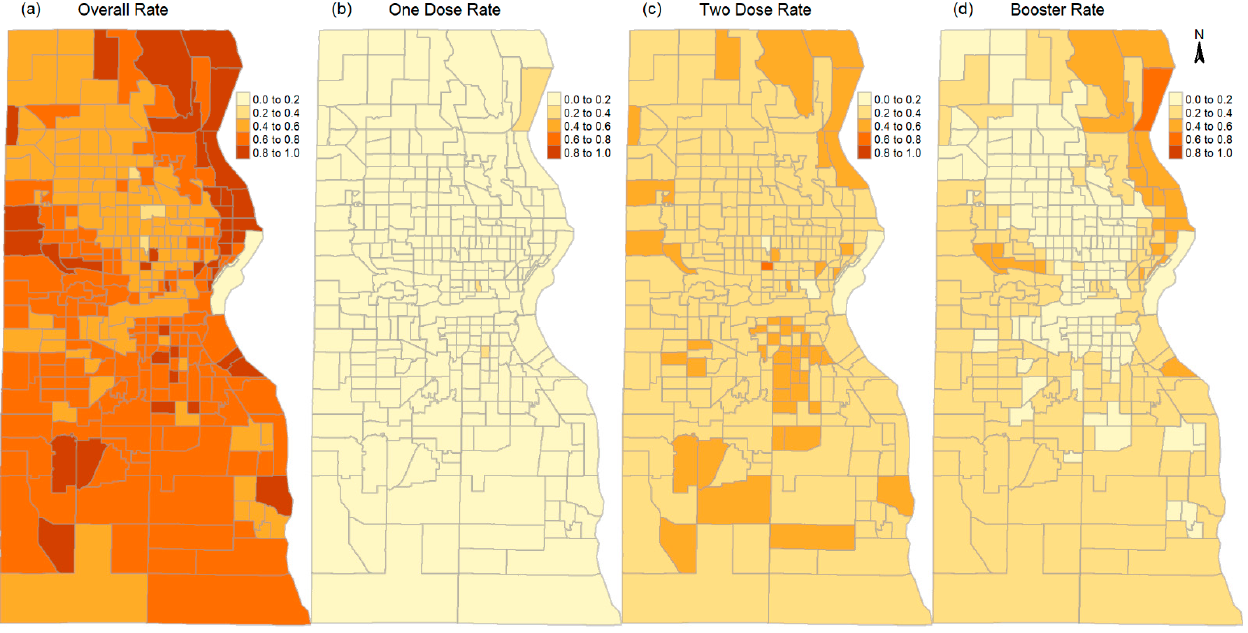
Figure 4. Age-adjusted vaccination rates in census tracts in Milwaukee: ( a ) overall rate; ( b ) one-dose rate; ( c ) two-dose rate; and ( d ) booster rate. rate; ( c ) two-dose rate; and ( d ) booster